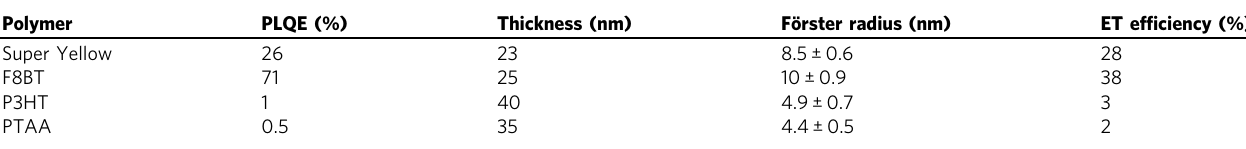
Table 1 Förster radius and energy-transfer ef fi ciencies for a range of polymers on MAPbI 3 . For each polymer type (Super Yellow, F8BT, P3HT and PTAA) deposited on MAPbI 3 :quartz, the extracted Förster radius is provided, giving a measure of the distance over which ET is effective for each polymer:MAPbI 3 material pair. The stated overall ef fi ciency of ET is speci fi c to the polymer fi lm thickness and PLQE